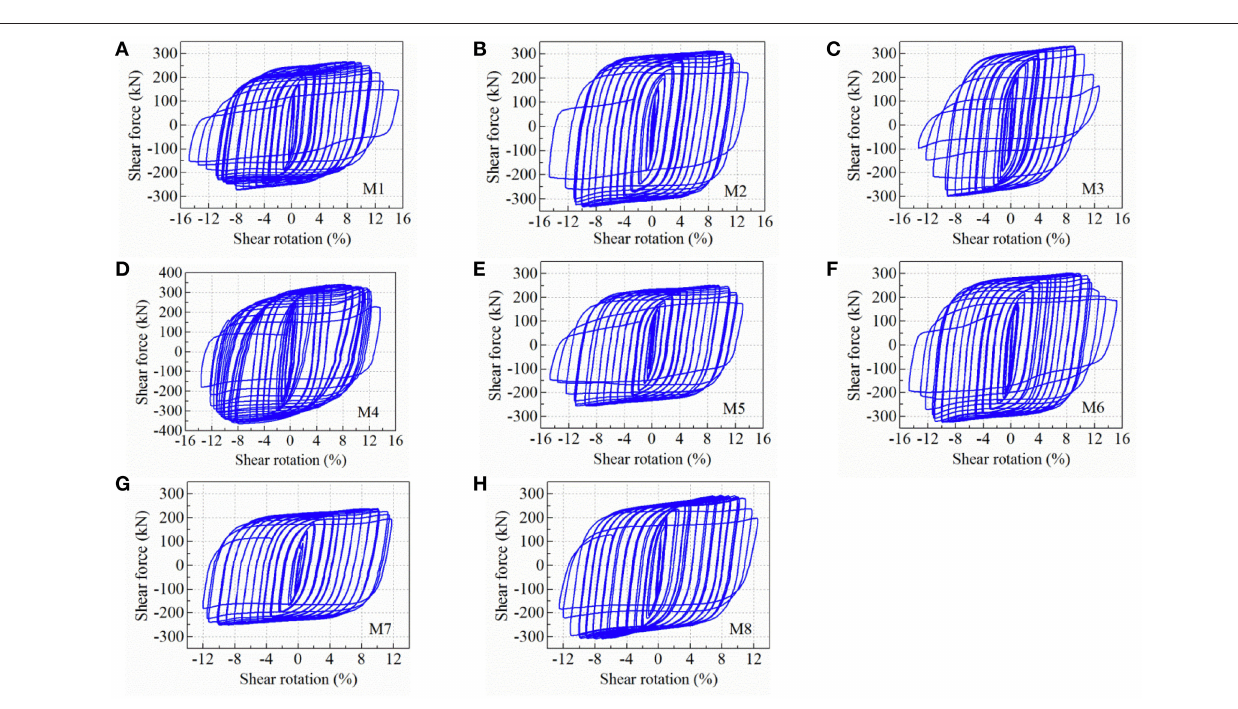
FIGURE 5 | Hysteretic curves of metallic dampers: (A) M1; (B) M2; (C) M3; (D) M4; (E) M5; (F) M6; (G) M7; (H)